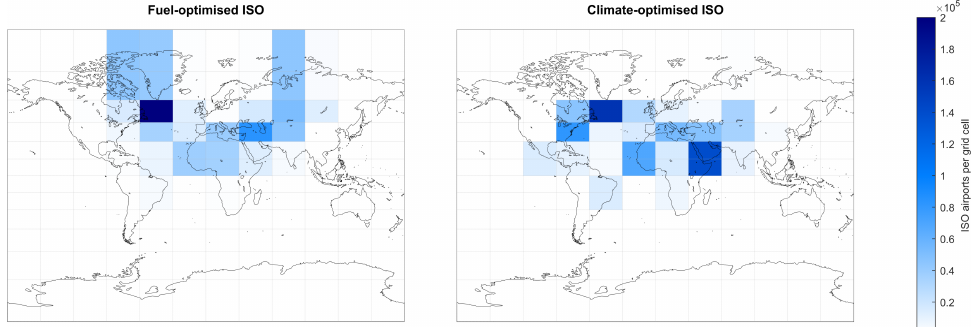
Figure 8. Distribution of additional take-offs and landings per grid cell with introduction of fuel- optimised ISO concept ( left ) and climate-optimised ISO concept ( right